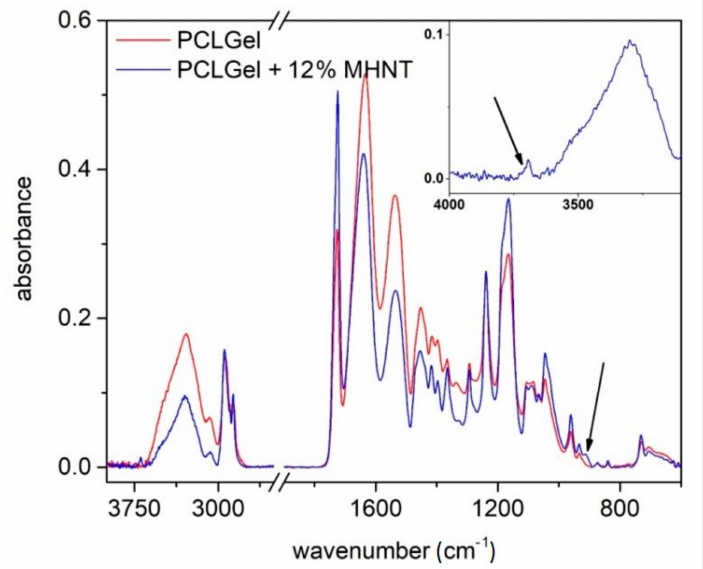
Figure 3. FTIR spectra of PCL/Gel nanofibers doped by magnetized HNT particles. The OH vibrations originating in MHNTs are highlighted by